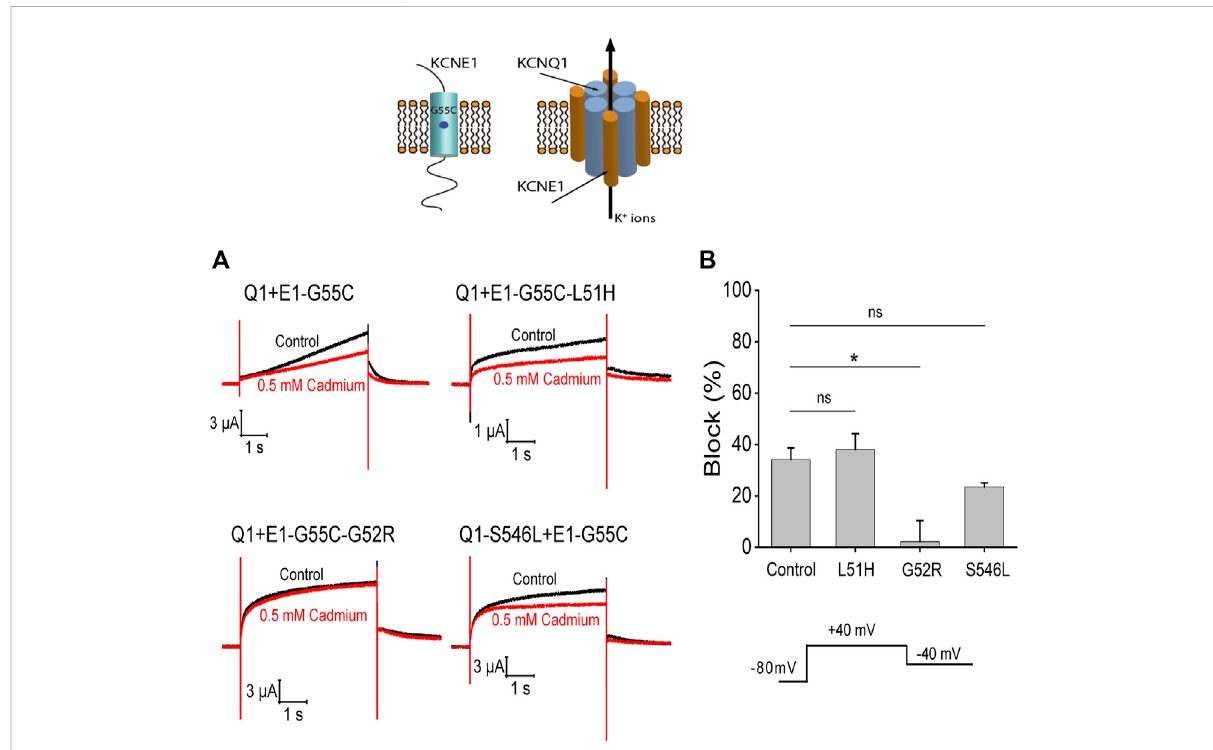
FIGURE 10 Cd 2+ sensitivityofKCNQ1andKCNE1mutants. (A) Currentsinresponsetovoltagestepto+40 mVfrom − 80 mVwithatailvoltageof − 40 mVin the absence (control) and presence of 0.5 mM cadmium. (B) Percent block of 0.5 mM cadmium for each mutation ( n > 3). Signi fi cance tested by ANOVA with the Dunnett ’ s test for multiple comparisons with Control (Q1+E1-G55C). Ns = non-signi fi cant, * p <